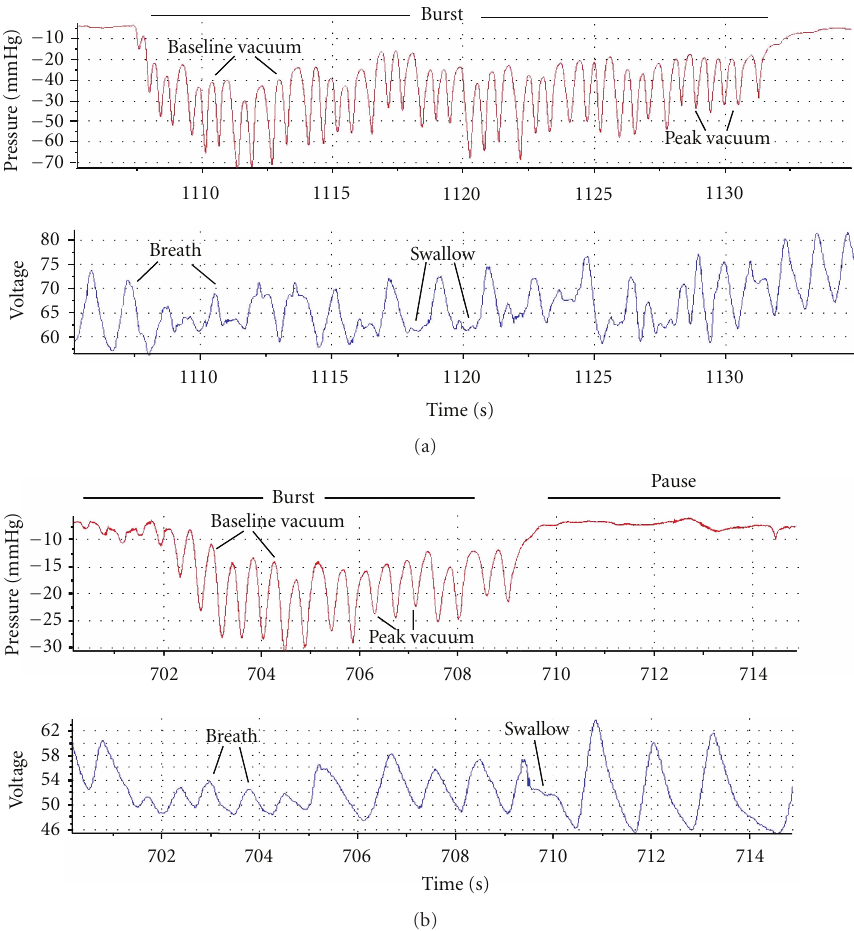
Figure 3: Trace of a suck-swallow-breathe burst of the infant during (a) nutritive sucking (NS) and (b) non-nutritive sucking (NNS) during the monitored feed from the teat. Similar to the breastfeed, during the NS burst, there are more sucks, swallows, and breaths and the burst is longer than